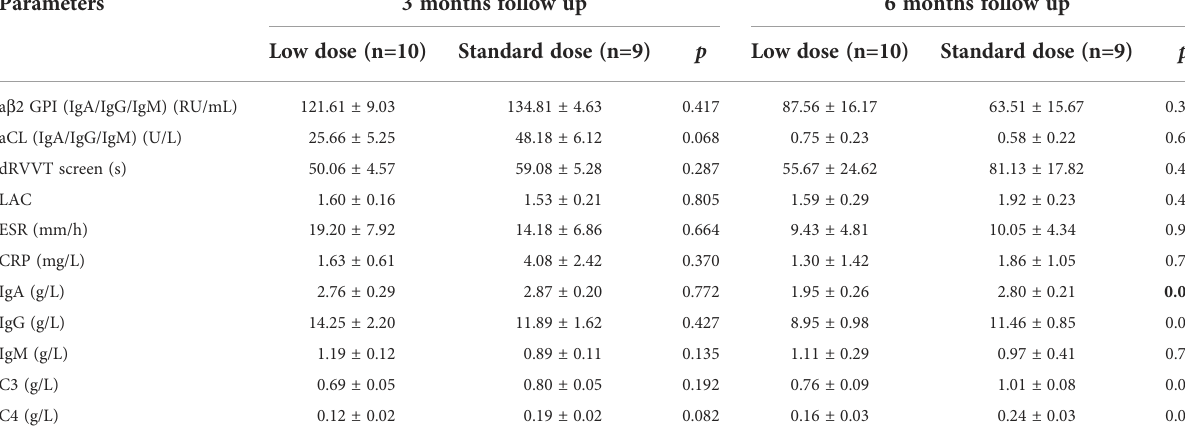
TABLE 4 Comparison of laboratory manifestations in APS patients between low dose versus standard dose at 3 months and 6 months follow up. Parameters 3 months follow up 6 months follow